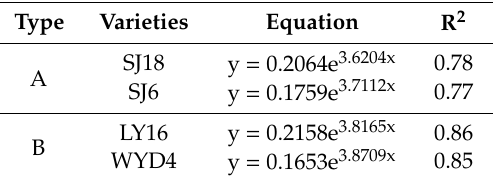
Table 6. Regression analysis results between the canopy volume parameter (CVP) and canopy cover (CC) according to Equation (4).